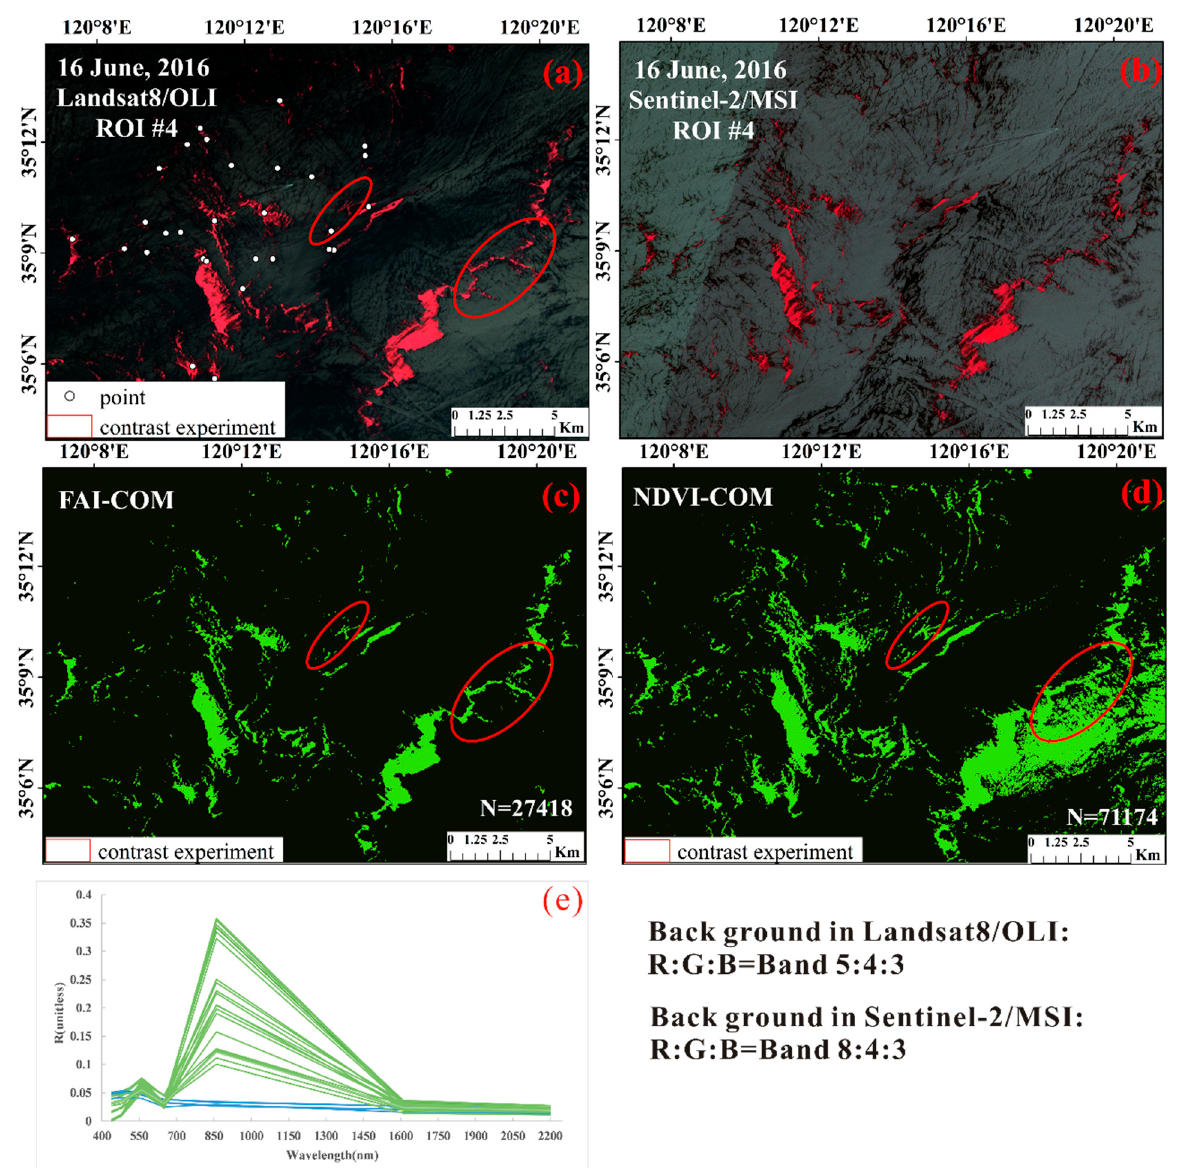
Figure 8. Comparison of U. prolifera extraction in #4 ROI on 16 June 2016. “N” means the number of U. prolifera pixels. ( a ) Landsat8/OLI pseudo-true-color image, R:G:B = band 5:4:3, ( b ) Sentinel-2/MSI pseudo-true-color image, R:G:B = band 8:4:3, ( c ) U. prolifera extracted from FAI-COM, ( d ) U. prolifera extracted from NDVI-COM, ( e ) reflectance spectra with random points of U. prolifera and seawater corresponding to the seven Landsat8 bands on 16 June 2016.